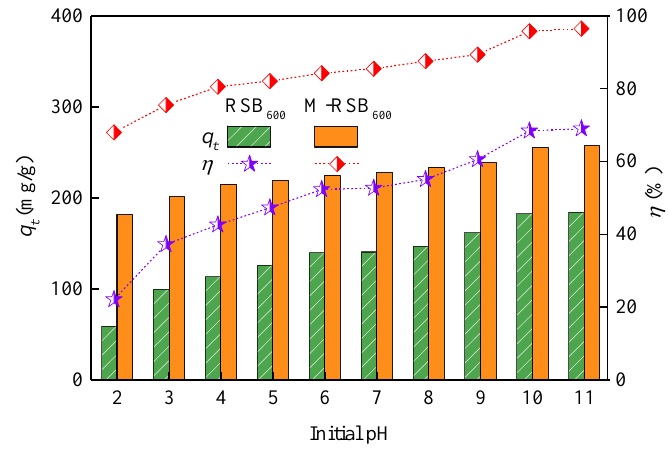
Figure 4. The adsorption performance under different initial pH.